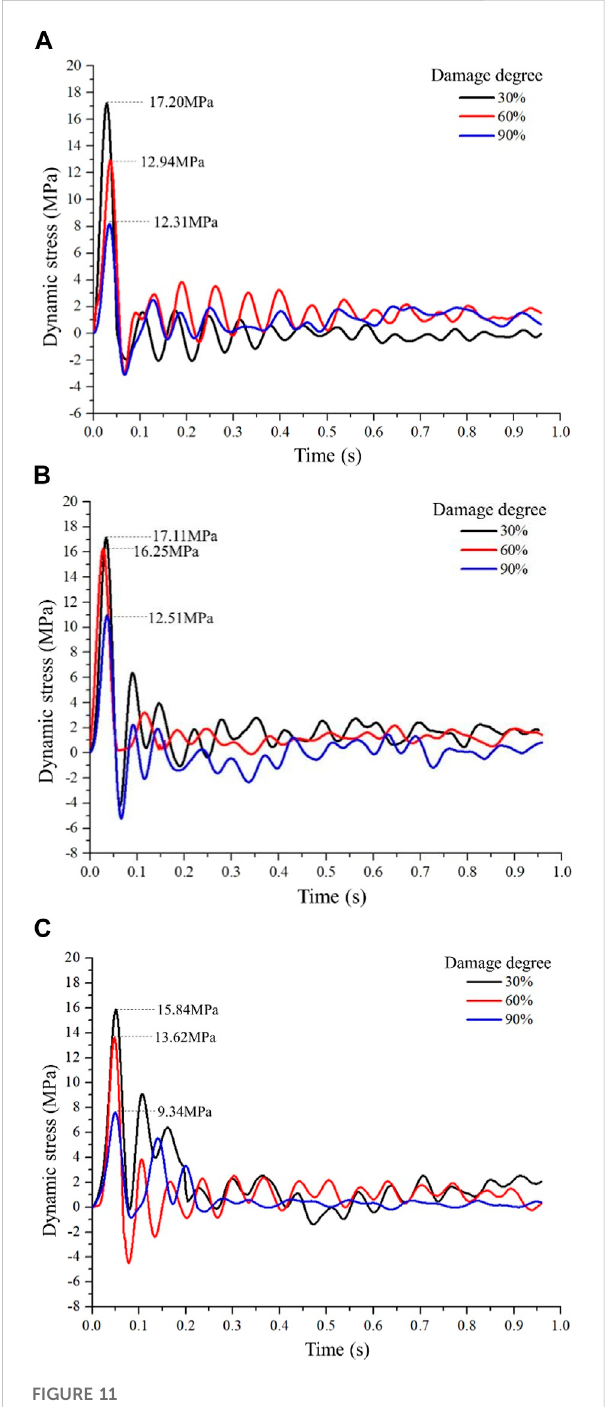
FIGURE 11 Dynamic stresses with different degrees of damage to the cracked zone for monitoring points located at the inner wall of (A) roadway top, (B) roadway side, and (C) roadway